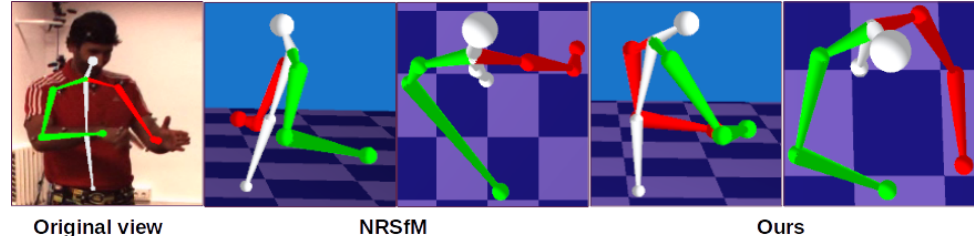
Figure 2. Side-by-side comparison of the non-rigid structure from motion (NRSfM) method [11] and our SfAM. Reconstruction results of [11] violate anthropometric properties of the human skeleton due to changing bone lengths from frame to